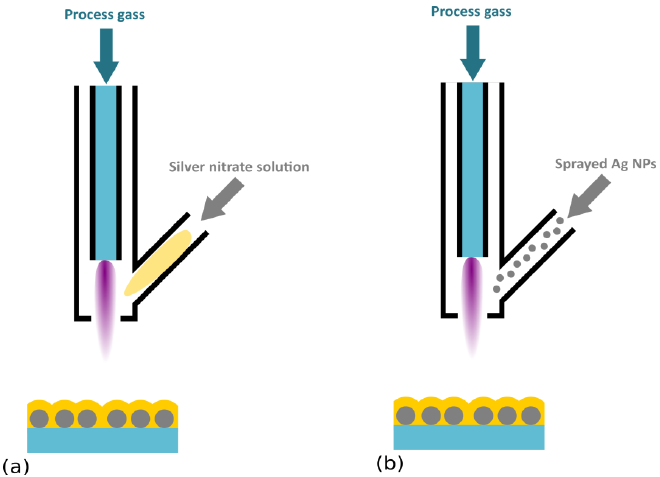
Figure 5. Schematic representation of atmospheric pressure plasma systems for the deposition of Ag/plasma polymer nanocomposites. ( a ) Plasma jet with injection of silver nitrate solution, and ( b ) plasma jet fed with suspension of Ag NPs.